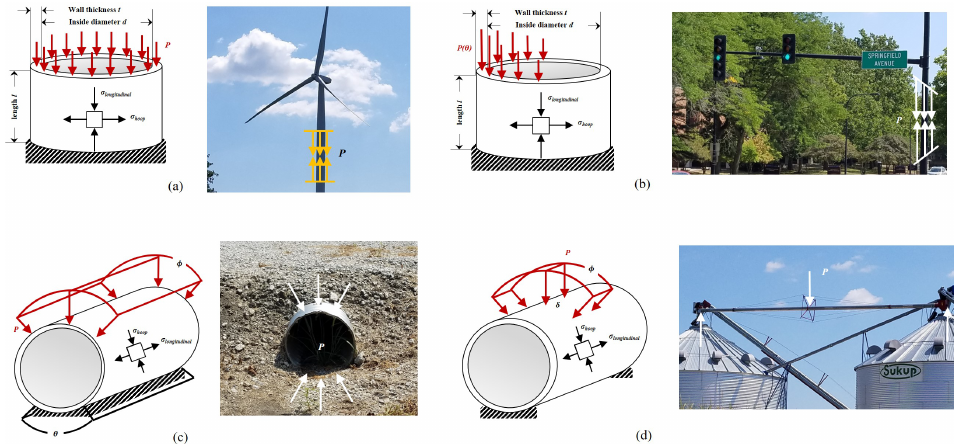
Figure 3. Example loadings (taken from [12] and reused under CC-by 4.0 license): ( a ) uniform axial (e.g., balanced windmill tower), ( b ) non-uniform axial (e.g., non-symmetric traffic light tower), ( c ) angled radial (full-length loading) (e.g., culvert under a road), and ( d ) angled radial (local loading) (e.g., grain bin transfer shaft with guide